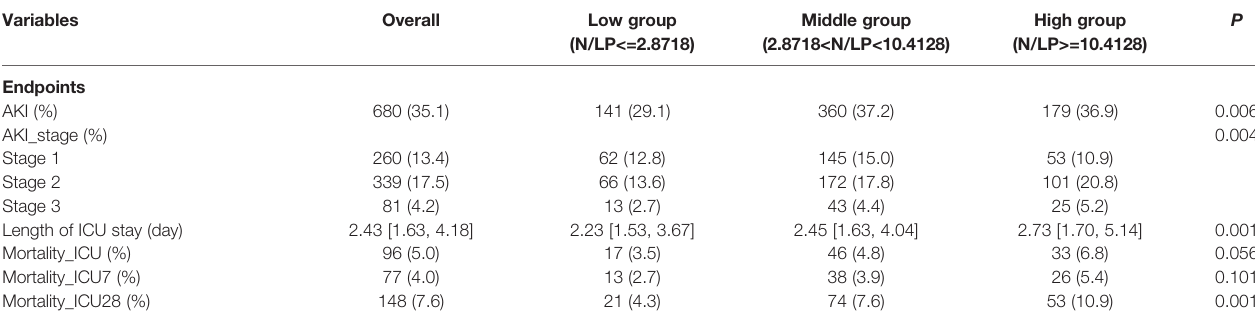
Table 2 summarized the results of Cox proportional hazard models. Three statistical models with various adjusted confounders revealed that the hazard ratio (HR) and 95% con fi dence interval (CI) for both middle and high groups were larger than 1.0, indicating a higher incidence of AKI than the low N/LP group. In Model 2, after adjusting for all sixteen covariates, the HR (95%CI) for the middle and high groups was 1.30 (1.07, 1.58) ( P =0.008) and 1.27 (1.02, 1.59) ( P =0.034), respectively. It